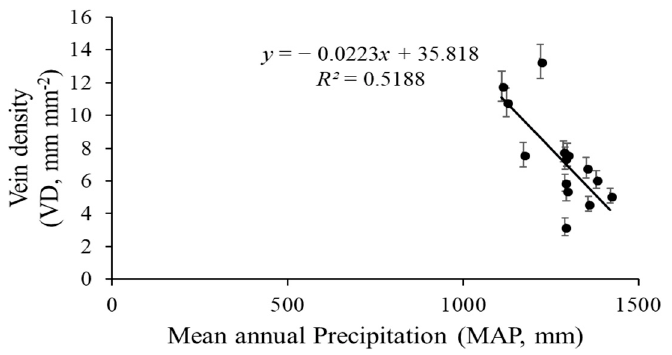
Figure 7. Regression analysis between P. subaequalis of vein density (VD) and the climatic factors of mean annual precipitation (MAP) in 14 sampling sites across eastern China. Each dot represents a sampling site in China. ( p = 0.001).